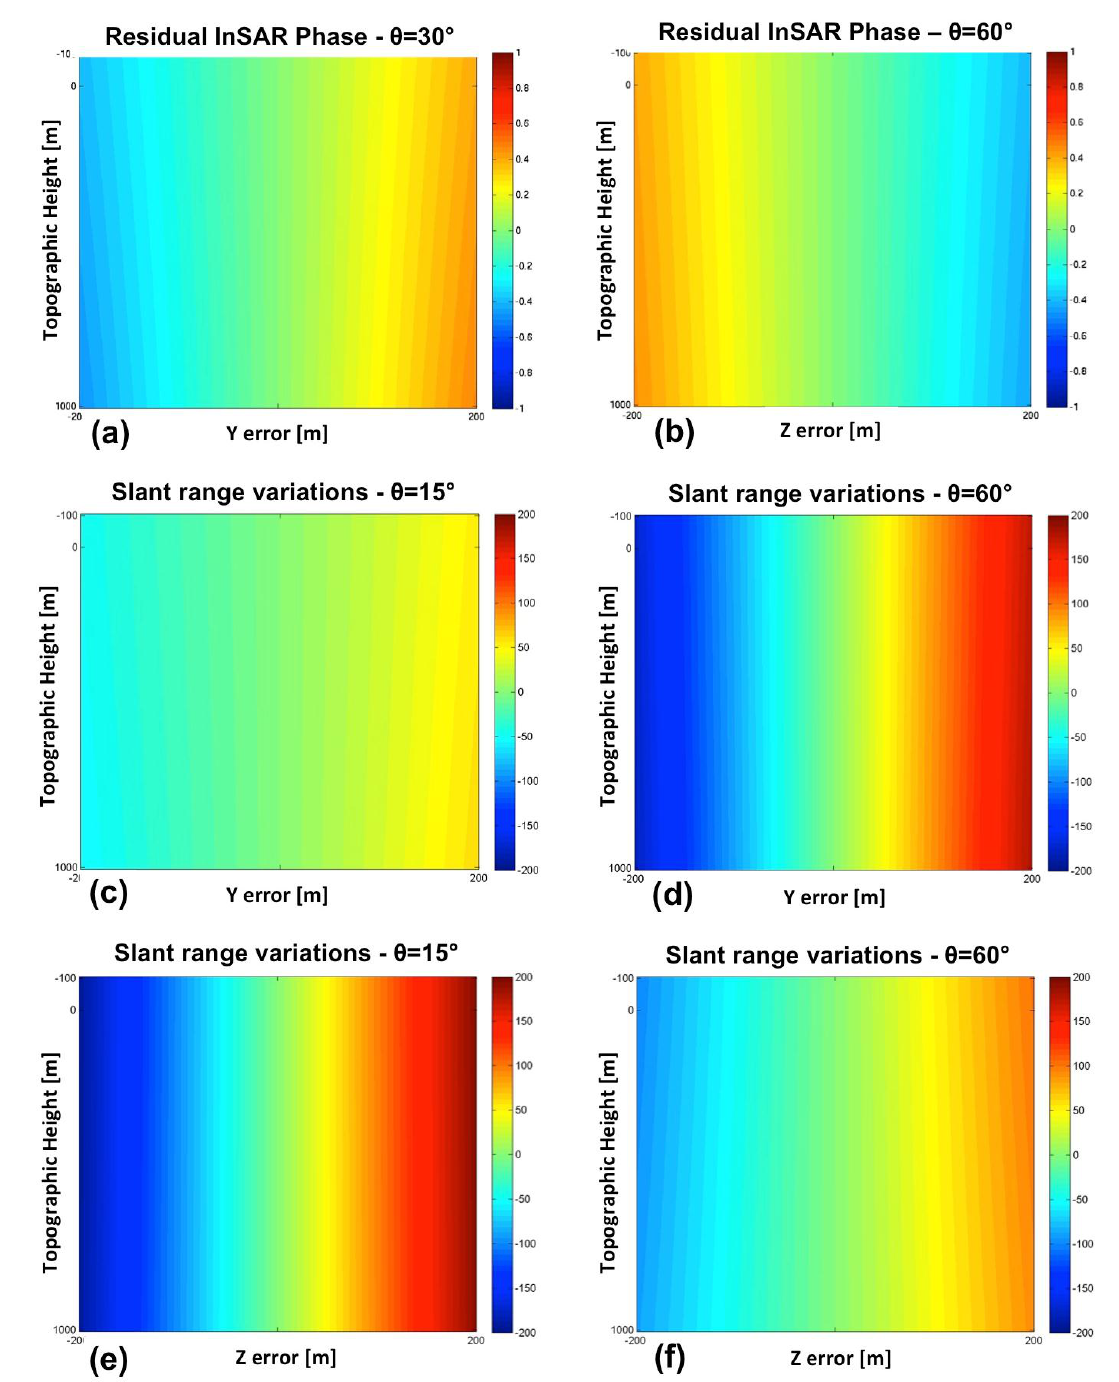
Figure 13. Subplots ( a ) and ( b ) show residual InSAR phase cycles evaluated for Y errors ( a ) and Z errors ( b ) ranging from −200 to 200 m, and incident angles at mid-range and far range respectively. Subplots ( c – f ) show the variation of the target position along slant rage (meters) evaluated for Y errors ( c , d) and Z errors ( e , f ) ranging from −200 to 200 m, and for incident angle at near range ( c , e ) and far range ( d , f ). For all the plots, the topographic height ranges from −100 m to